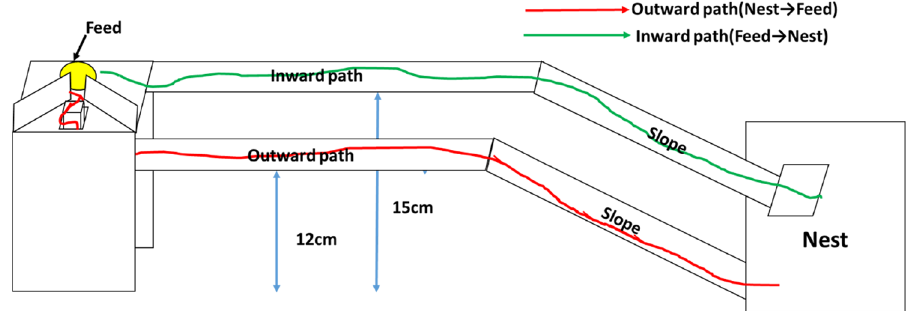
Figure 1. The main apparatus used in the three experiments (the main experiment and the comparison experiments 1 and 2). Nests are connected to the experimental apparatus by a slope. In the main experiment, on the outward path, there is ant traffic from the nest to the feeding site on a pheromone trail, and on the inward path, there is ant traffic from the feeding site to the nest on a pheromone trail. In the comparison experiment 1, only a pheromone trail is present on both the outward and inward paths. In the comparison experiment 2, no pheromone trail or ant traffic is present on both the outward and inward